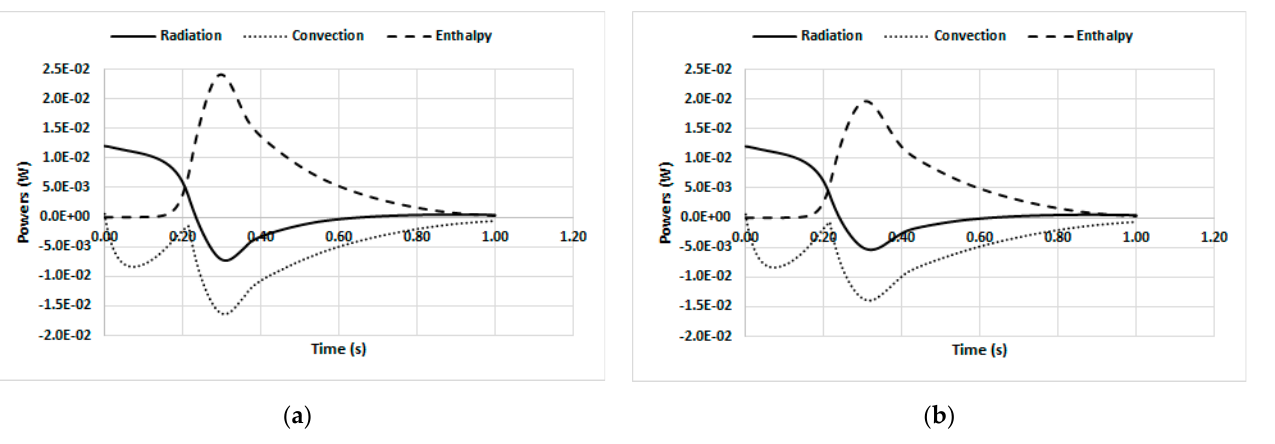
Figure 5. Values of the radiation (solid line), convection (dotted line) and enthalpy (hyphened line) terms in the right-hand side of (3) versus time, according to Campbell’s ( a ) and Laurendeau’s ( b ) equations, and for the regulation temperature of the reactor equal to 1200 °C.